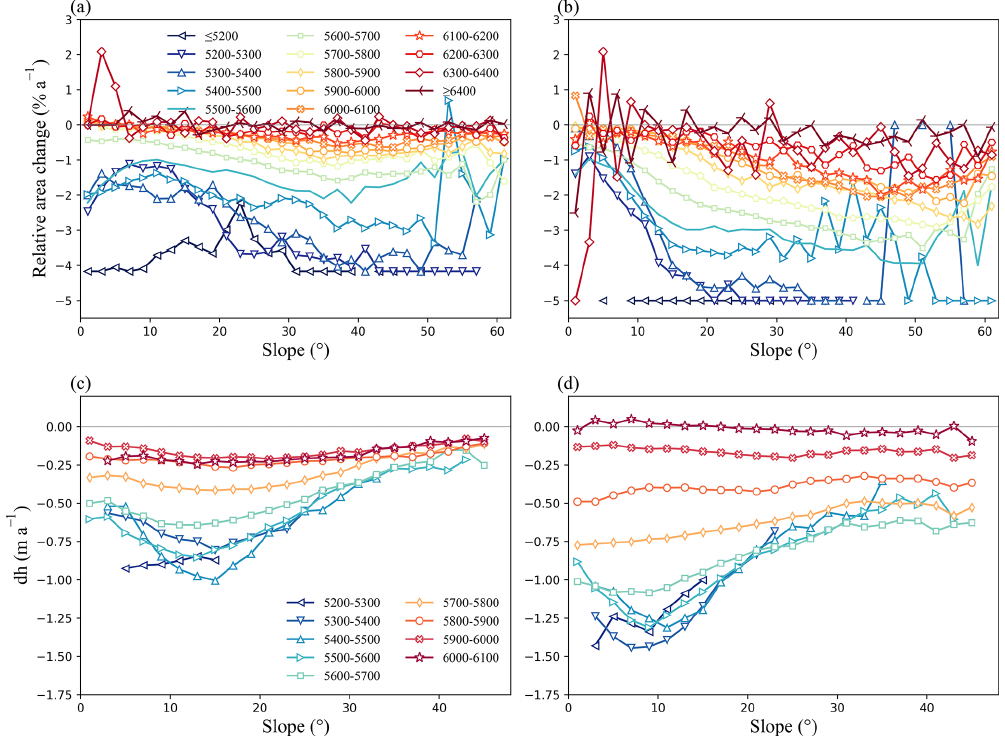
Figure 9. Glacier area changes with slope during 1976–2000 (a) and 2000–2020 (b) and glacier elevation changes with slope during 1976– 2000 (c) and 2000–2020 (d) .